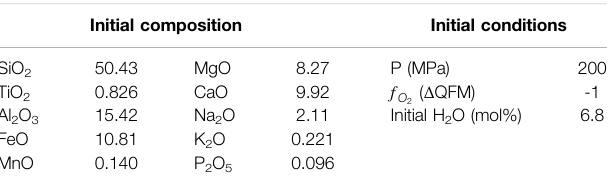
TABLE 1 | Initial composition (wt%) and conditions of the FC rhyolite-MELTS model used as test for the MushPEC